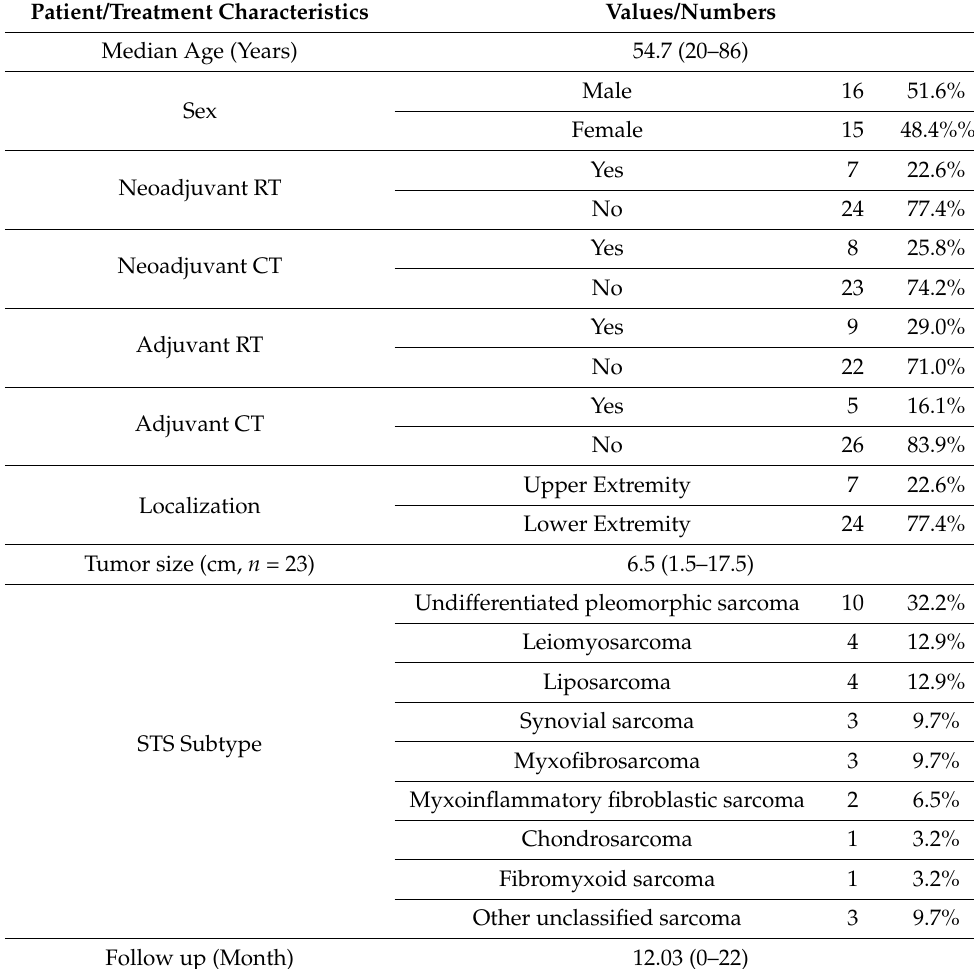
Table 1. Characteristics of the 31 included patients (Sarcoma Center, University Hospital Erlangen) including Age, Sex, Radiotherapy (RT), Chemotherapy (CT), Localization, Tumor size, Soft tissue sarcoma (STS) Subtype and Follow up.